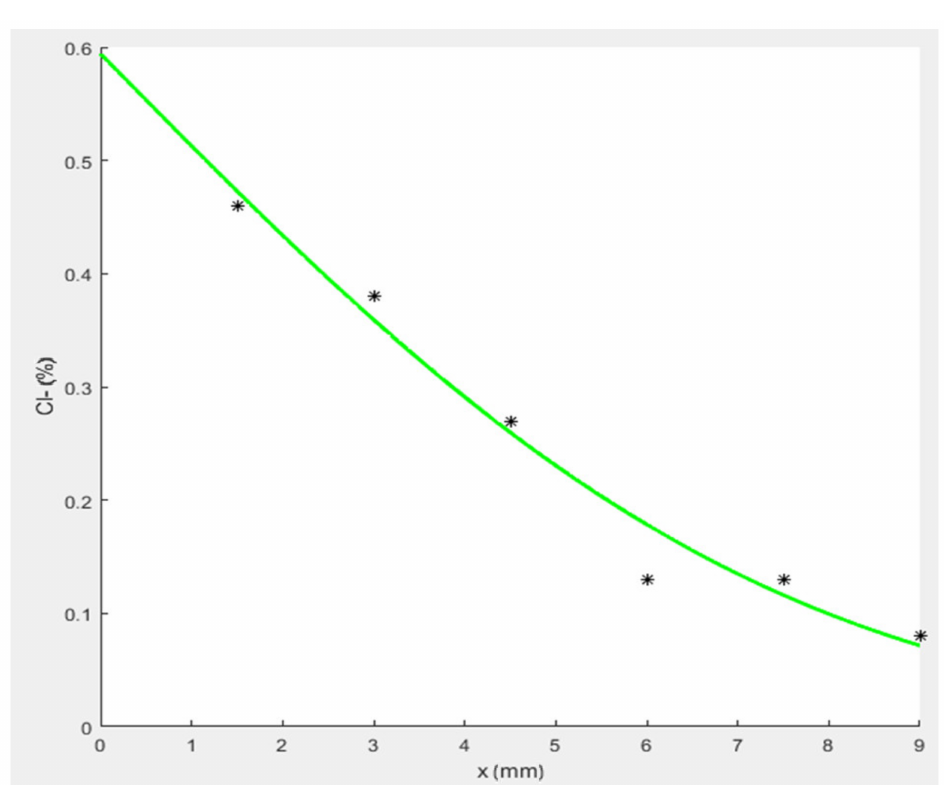
Figure 3. Example of the chloride profile, showing the values from the experiment and the interleaved curve according to Equation